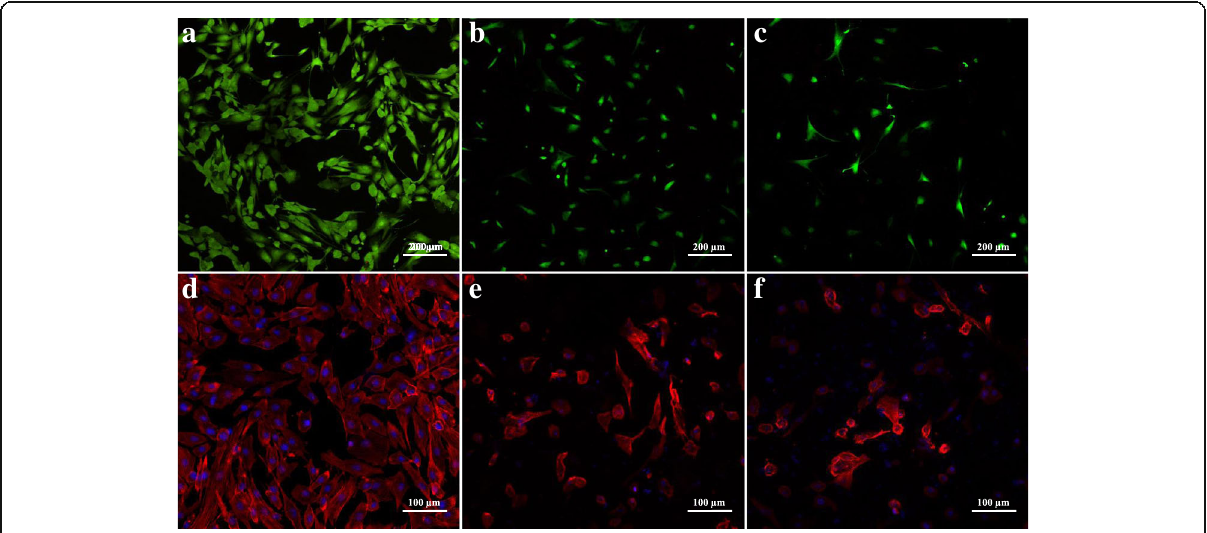
Fig. 9 Confocal micrographs of fibroblasts seeded on a , d fibronectin-coated glass; b , e unloaded CS-PEO/Fb scaffold; and c , f PDGF-loaded (4 μ g/mL) CS-PEO/Fb scaffolds. a – c Cells were stained with LIVE/DEAD ™ : live cells (green), dead cells (red). d – f Cells were stained with DAPI (blue) and phalloidin